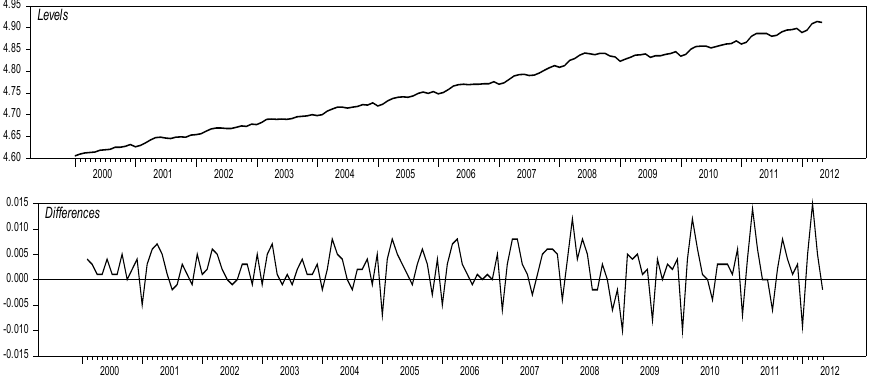
Figure 7. Logarithmic consumer price index in the Eurozone. Data vector January 2000 to May 2012 (Great Depression).